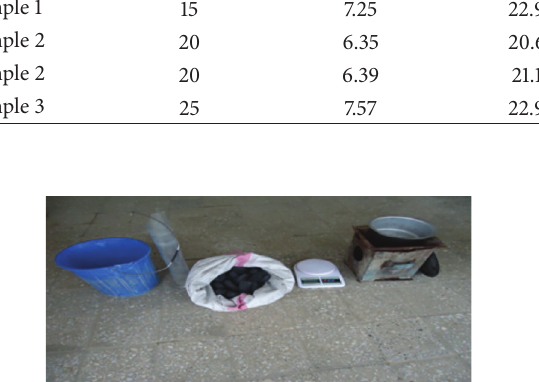
Figure 5: Boiling test equipment (from left to right: water holding basket, measuring cylinder, briquettes, digital weight meter, and